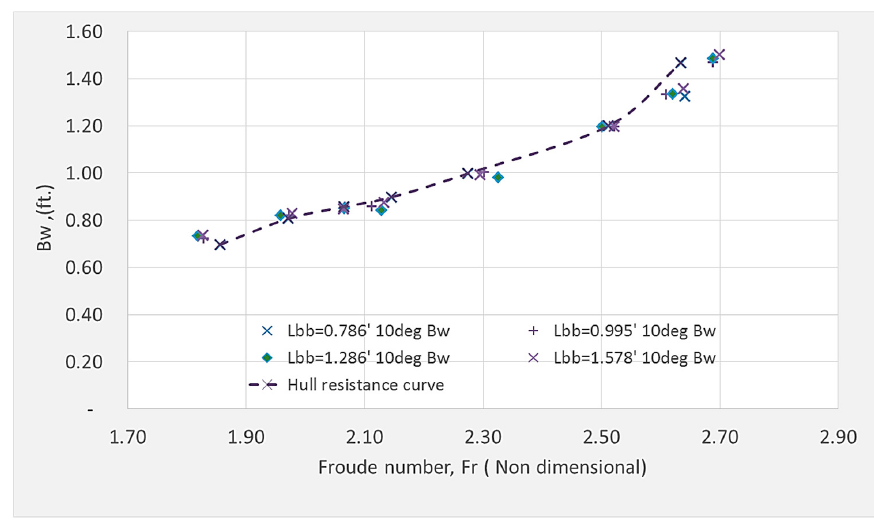
◦ pitch angle. w for 10